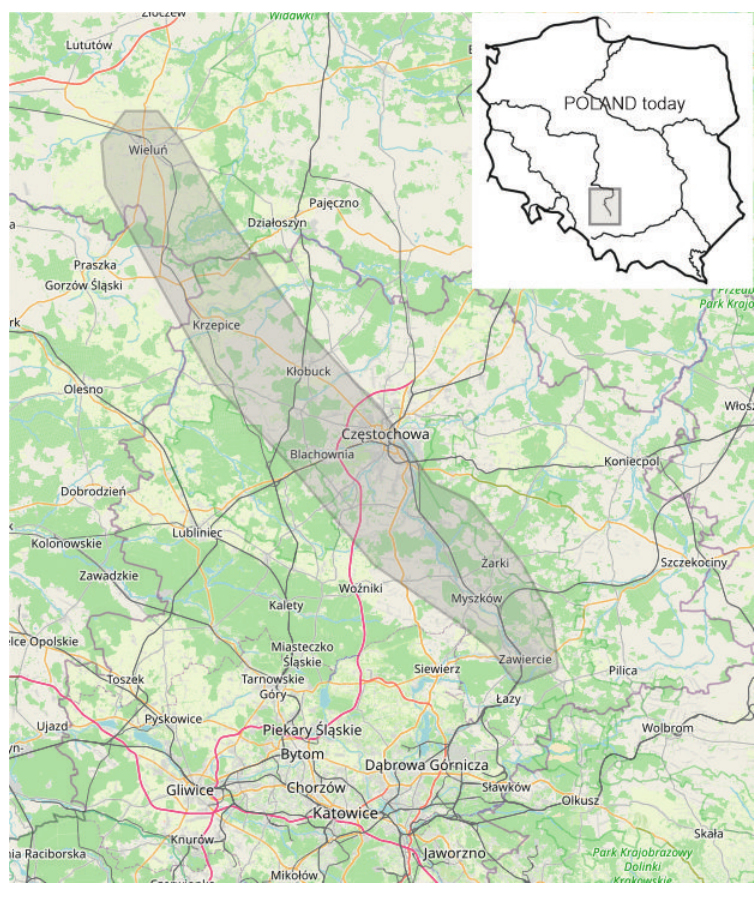
Figure 6. Czestochowa Ore-bearing Area (own